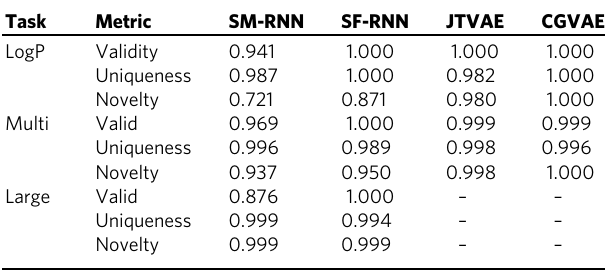
Table 3 Standard metrics validity, uniqueness and novelty of molecules generated by all models in every